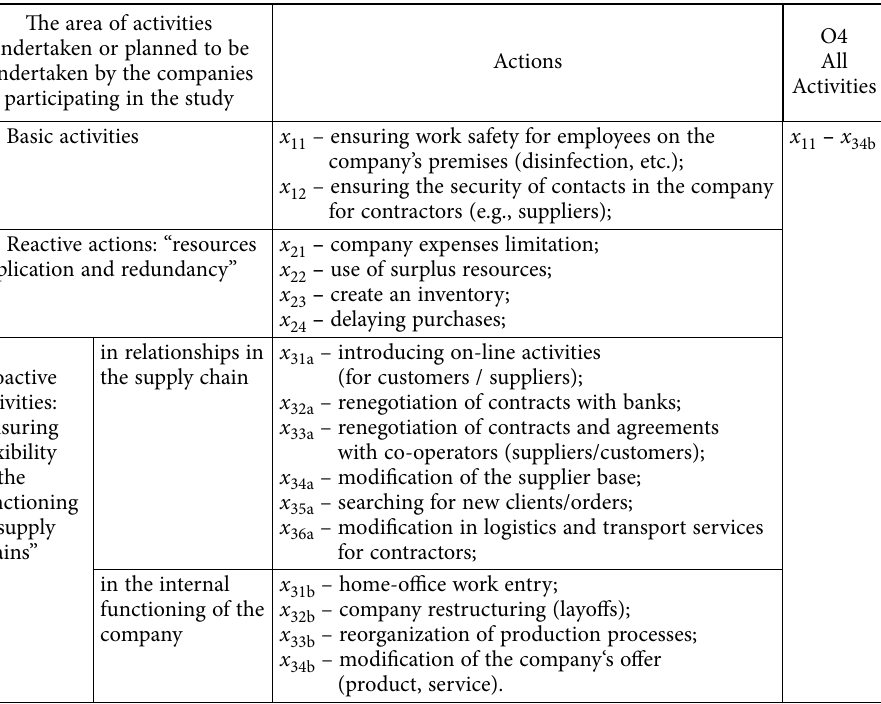
Table 2. Structure of the activities of double-loop learning assessed in the study, undertaken in manu- facturing supply chains under epidemiological